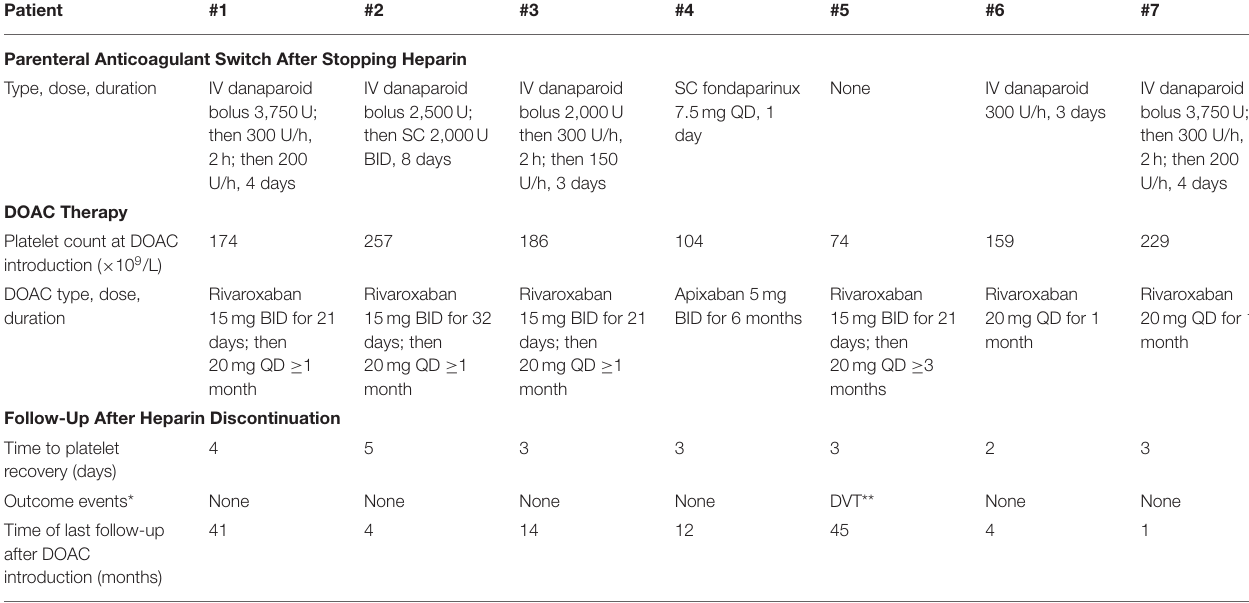
TABLE 2 | Management of HIT-suspected